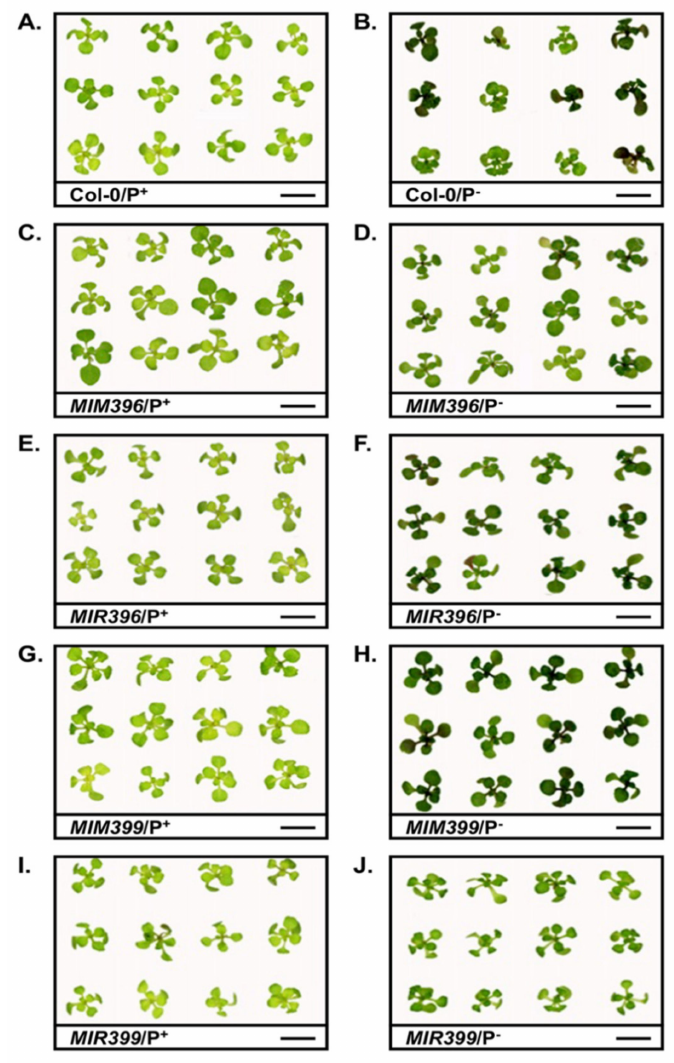
Figure 1. Phenotypes displayed by 15-day-old control-grown and PO 4 -starved Col-0, MIM396 , MIR396 , MIM399 and MIR399 seedlings. Phenotypes displayed by 15-day-old ( A ) Col-0/P + , ( B ) Col-0/P - , ( C ) MIM396 /P + , ( D ) MIM396 /P - , ( E ) MIR396 /P + , ( F ) MIR396 /P - , ( G ) MIM399 /P + , ( H ) MIM399 /P - , ( I ) MIR399 /P + , and ( J ) MIR399 /P - seedlings. ( A – J ) Scale bar = 1.0